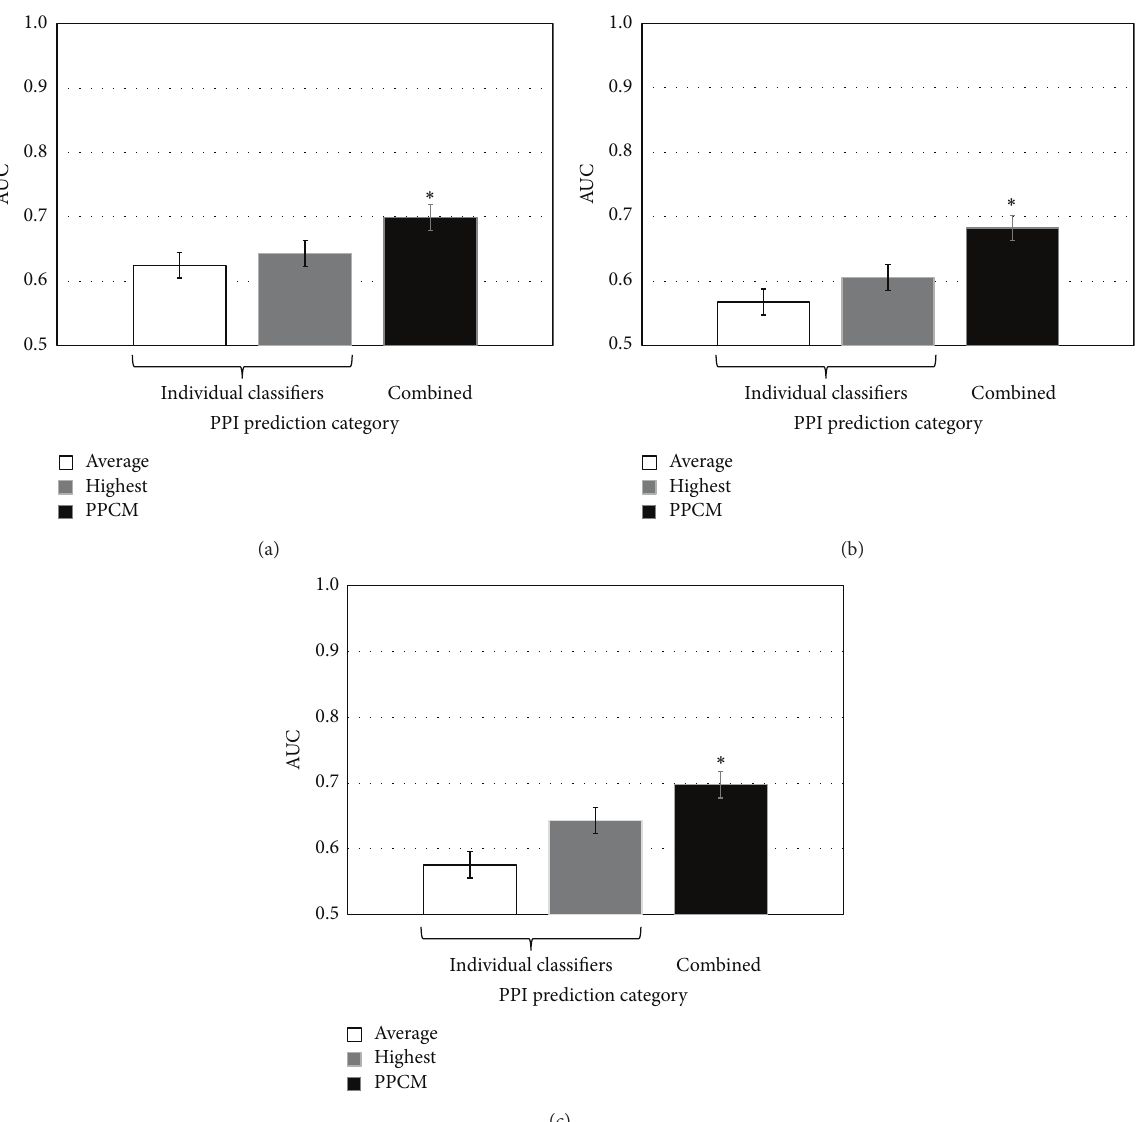
Figure 2: Comparison of PPI prediction accuracy in the GO2PPI category. (a) PPI prediction based on classifiers related to SC. (b) PPI prediction based on classifiers related to cross species. (c) PPI prediction based on classifiers related to all species. “Average” represents the mean AUC of all the classifiers in each category. “Highest” represents the classifier with highest AUC among all the classifiers in each category. Error bars show standard deviation. “ ∗ ” indicates that AUC of PPCM was significantly ( 𝑃 value < 0.05; 𝑡 -test) higher than that of the most accurate classifier in each